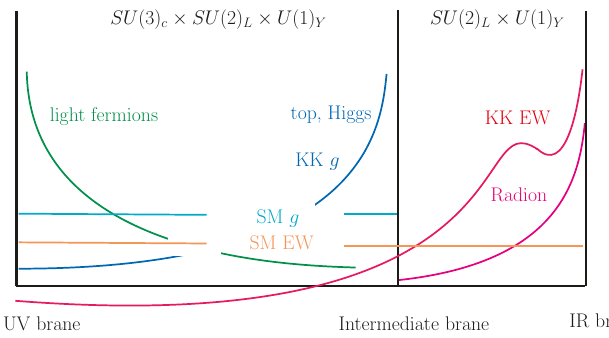
Figure 9. The extended warped extra dimensional model with only SM EW gauge (cid:12)elds in the full bulk (between UV and IR brane), but matter, Higgs and other gauge (cid:12)elds in subspace (between UV and intermediate brane). Schematic shapes of pro(cid:12)les for various particles (zero mode SM fermions and gauge bosons, an (IR) radion, and a generic KK mode) are